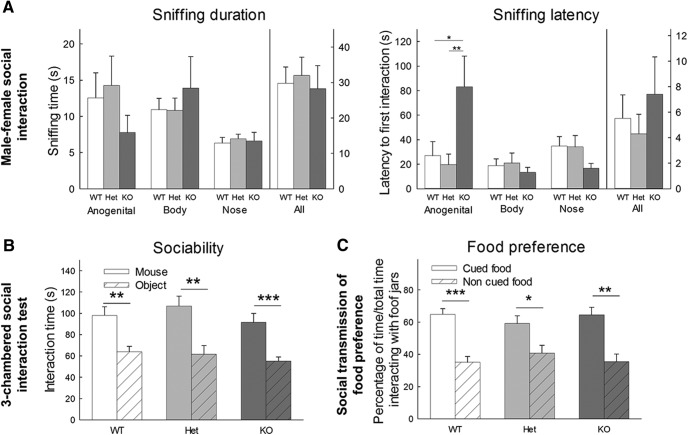
Social behavior of Shank3Δ4-22-deficient mice. A, Male social interaction in response to the presentation of an unfamiliar conspecific female in estrus and scored by the cumulative sniffing time and latency from the male toward different body regions of the female. No genotype differences were evident in the dyadic male-female social interaction for the overall sniffing time from the male toward the female, however a trend toward a decrease in anogenital sniffing as well as a significant increase of the latency to initiate the first anogenital sniffing event was observed in Shank3Δ4-22 homozygous mice. B, Preference for social stimulus in the three-chambered social interaction test measured by cumulative time interacting with either a mouse or an inanimate object. All three genotypes demonstrated a significant preference for an unfamiliar mouse over a nonsocial object. C, Social transmission of food preference measured by the time spent by the test mouse sniffing the demonstrator mouse and the time spent interacting with both cued and noncued food. All genotypes had a strong preference for the food flavor presented by the demonstrator mouse. USVs and time spent sniffing the demonstrator during the demonstrator interaction phase are displayed in Extended Data Figure 5-1. WT, wild-type mice; Het, heterozygous mice; KO, homozygous knock-out mice. *p < 0.05, **p < 0.1, ***p < 0.001.